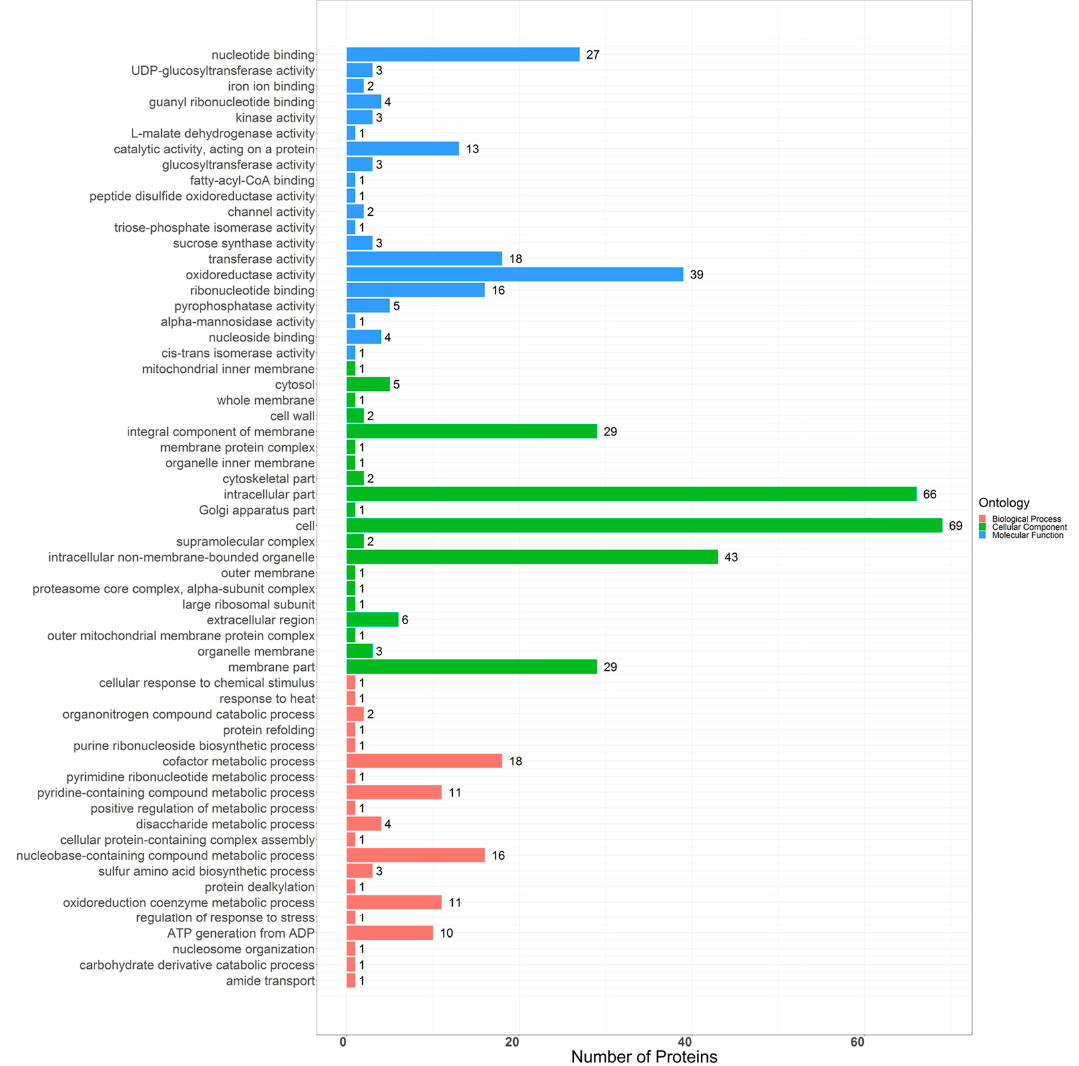
Figure 3. Gene ontology of differential proteins.